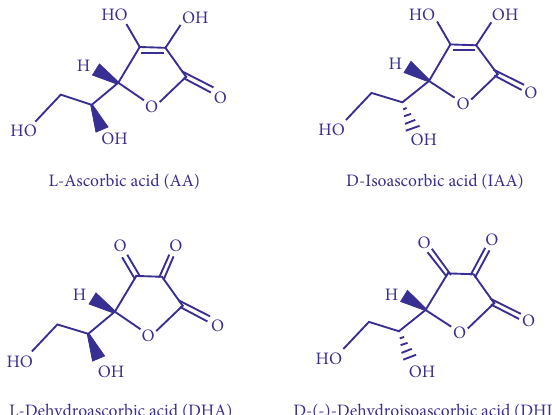
Scheme 1: Structures of L-ascorbic acid and D-isoascorbic acid and of their common oxidation forms L-dehydroascorbic acid and D- dehydroisoascorbic